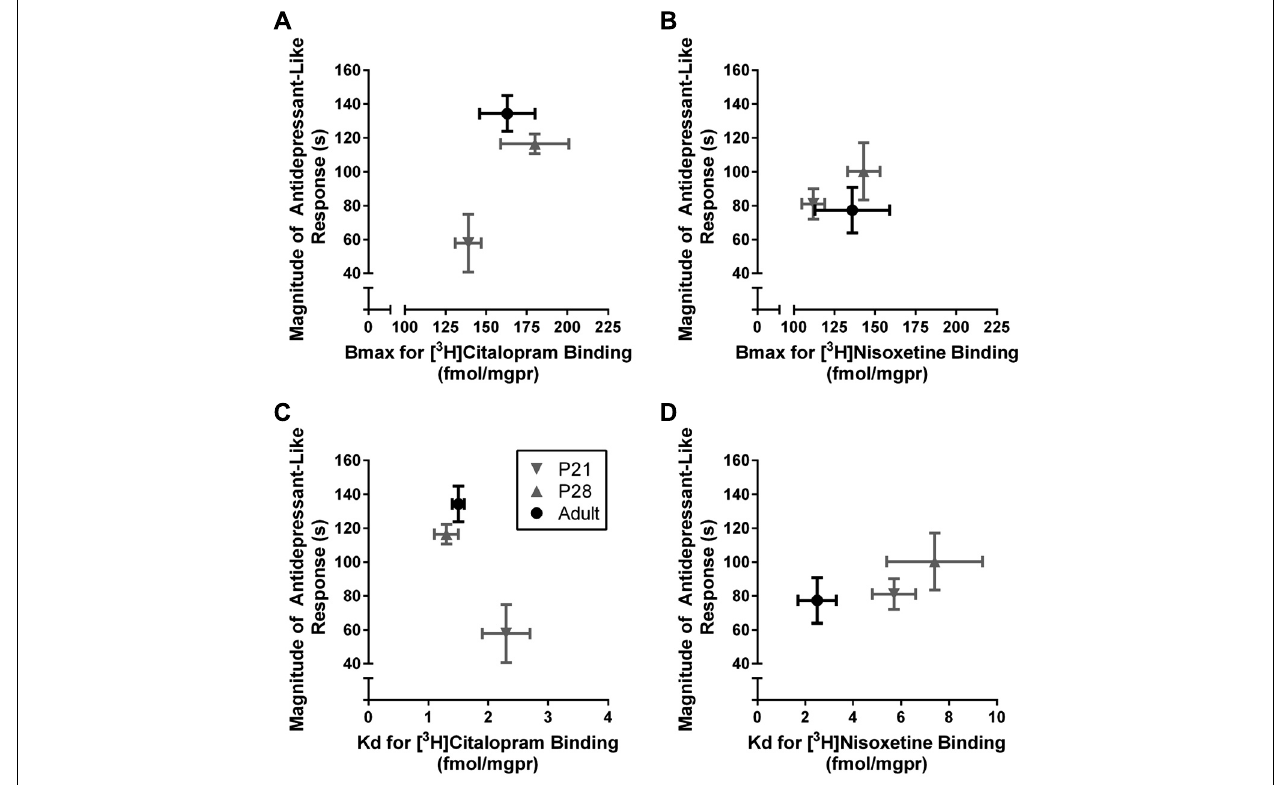
relatively constant across ages. Data are re-plotted from Figure 2 and Table 1 . TST data from Figure 2 are plotted on the y -axis as “magnitude of Table 1 . Data are mean and